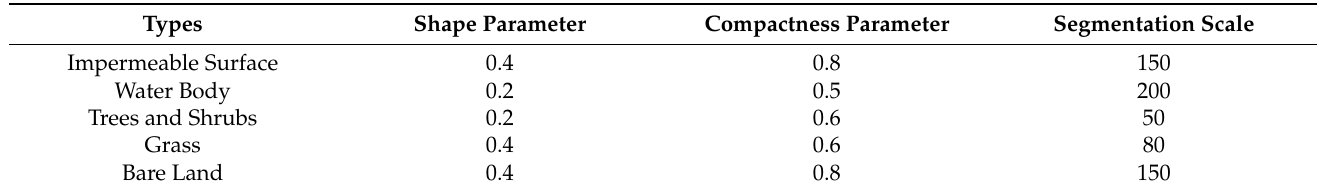
Table 2. Optimal segmentation parameters.